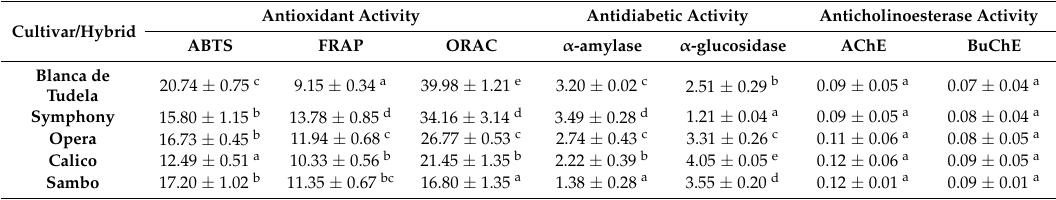
Table 4. Antioxidant (mmol Trolox/100 g), antidiabetic and anticholinoesterase (IC 50 ; mg/mL) activity of artichoke bracts.